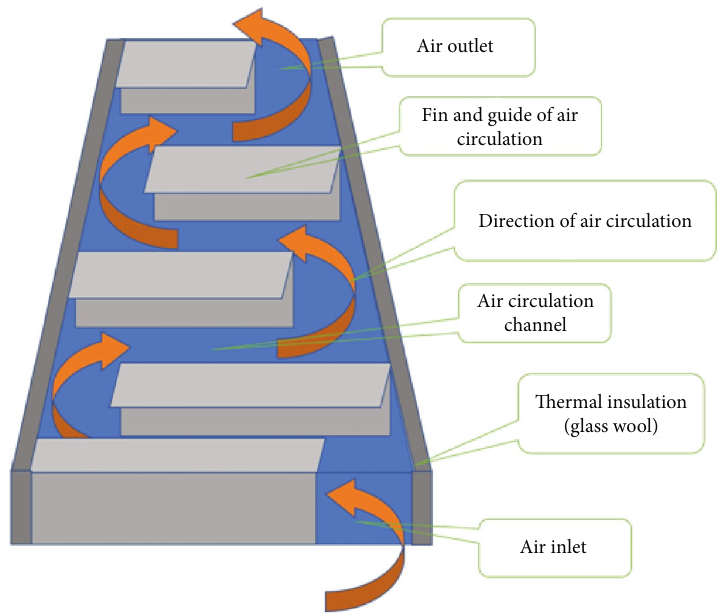
Figure 2: Schematic of solar thermal system. The solar PV panel is to set on the top of the solar thermal system.